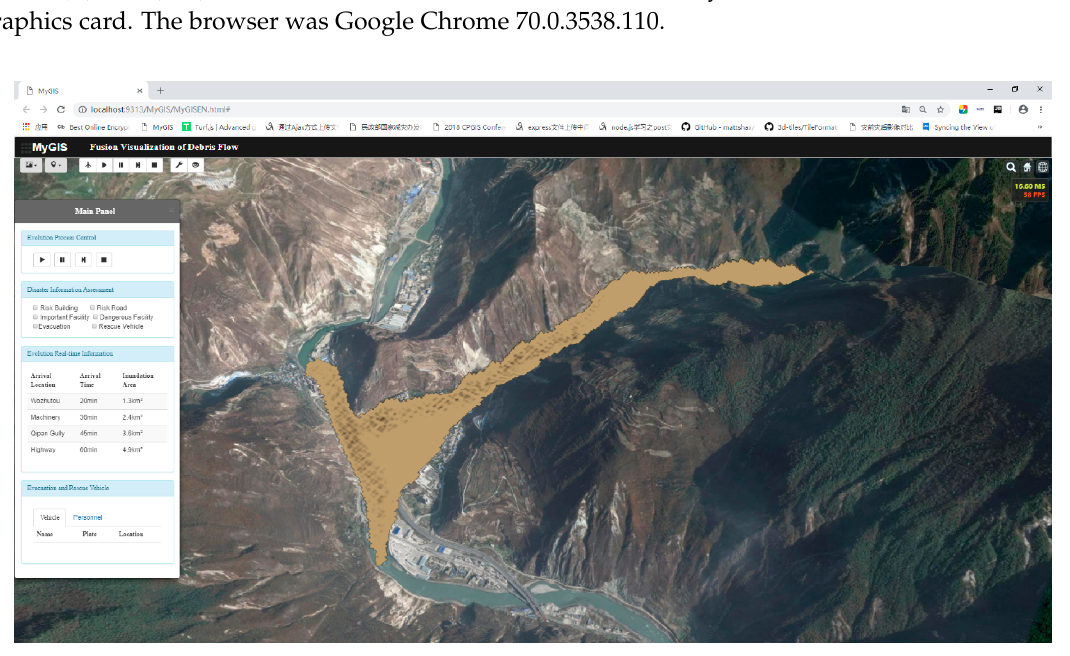
Figure 8. Prototype system and study area.